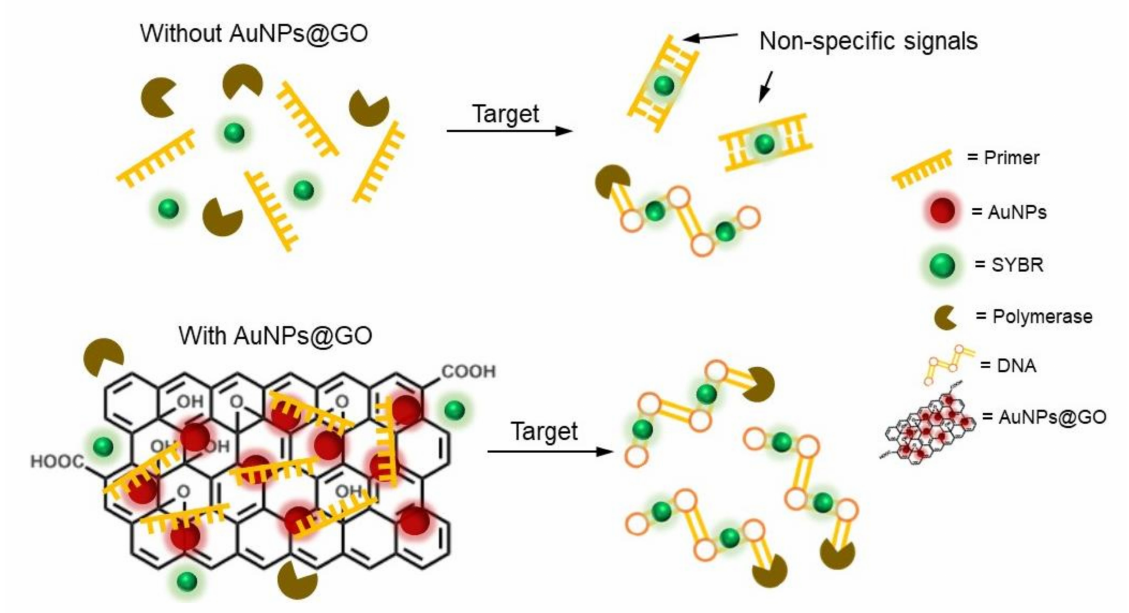
Figure 7. Schematic illustration of non-specific signal reduction using GO–AuNPs (AuNPs@GO) nanocomposite in a loop-mediated isothermal amplification (LAMP)